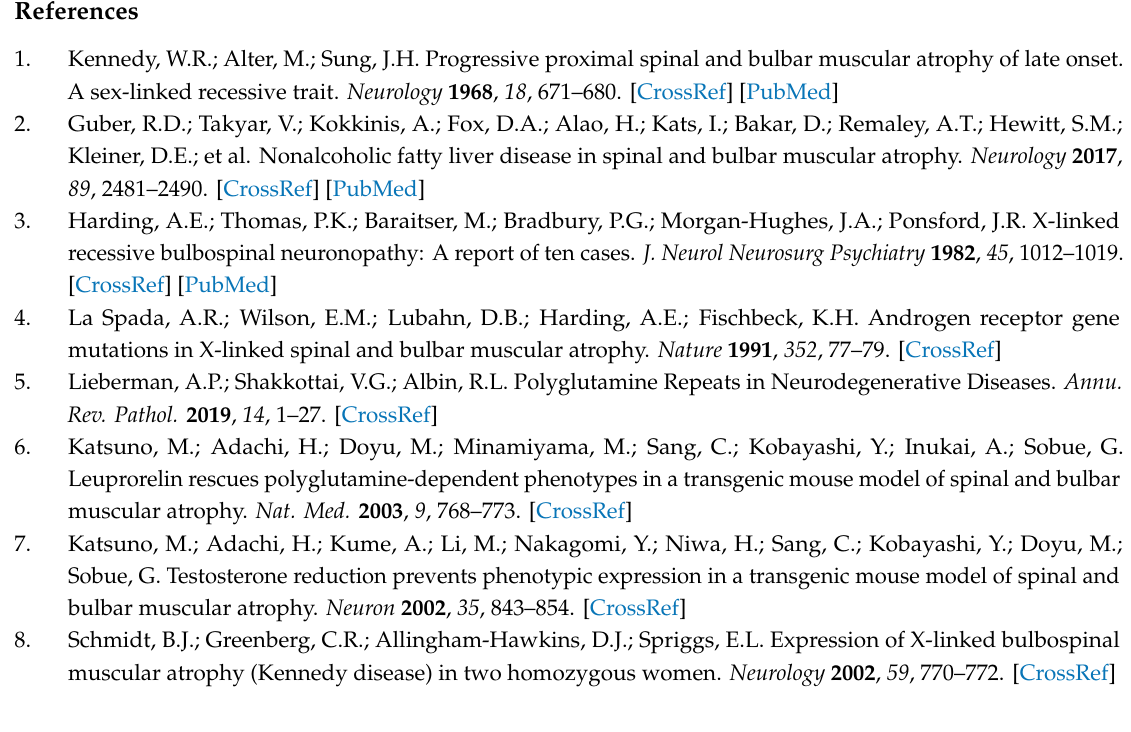
Figure S1: Decreased lifespan of female AR100Q mice and pictures of male mice; Figure S2: Absence of peripheral nerve pathology in AR24Q and AR100Q mice. Figure S3: Atrophy of glycolytic fibers exceeds that of oxidative fibers in AR100Q mice. Figure S4: Mitochondrial depolarization is age-dependent in AR100Q mice. Figure S5: PolyQ-expanded AR forms aggregates in spinal cord and brainstem. Figure S6: PolyQ-expanded AR forms 2% SDS-resistant aggregates selectively in skeletal muscle. Figure S7: PolyQ-expanded AR forms inclusion bodies in the muscle of AR100Q mice. Figure S8: PolyQ-expanded AR-positive inclusion bodies detected in sub-synaptic and non-sub-synaptic nuclei. Figure S9: Copy number of hAR transgene in iAR100Q mice. Figure S10: Generation and characterization of inducible transgenic mice expressing AR100Q. Figure S11: Two-week expression of polyQ-expanded AR in the adulthood does not cause metabolic alterations and fiber-type changes in muscle. Table S1: Primers Real Time used for quantitative PCR